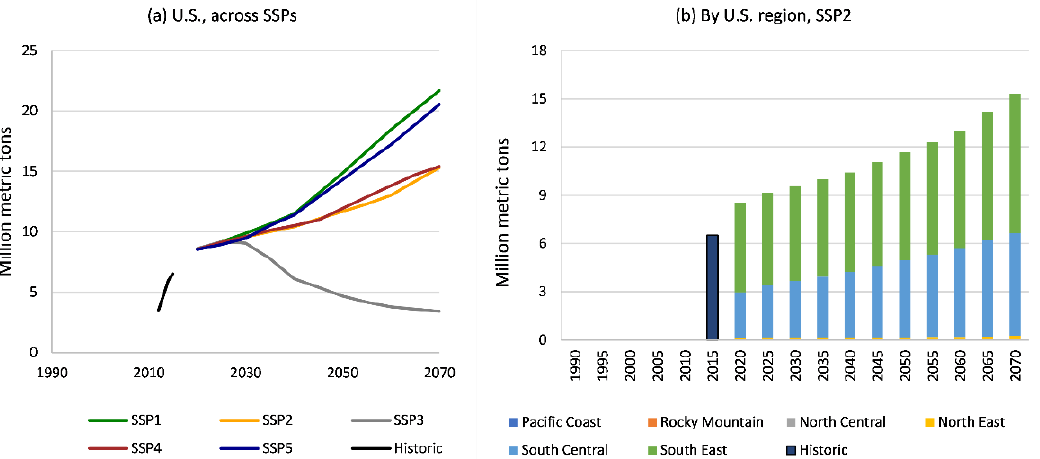
Figure 14. United States production of wood pellets ( a ) across SSPs and ( b ) by region within SSP2, 2012 to 2015 historic, 2020 to 2070 projections from FOROM.